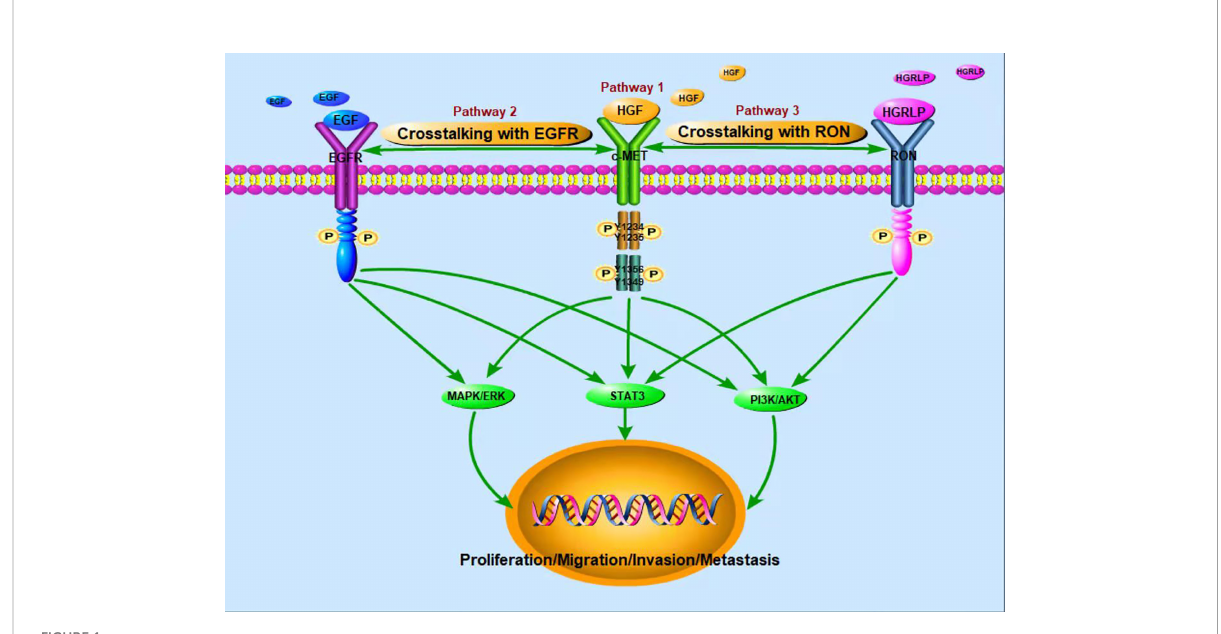
FIGURE 1 Activation of c-Met tumor-related signaling